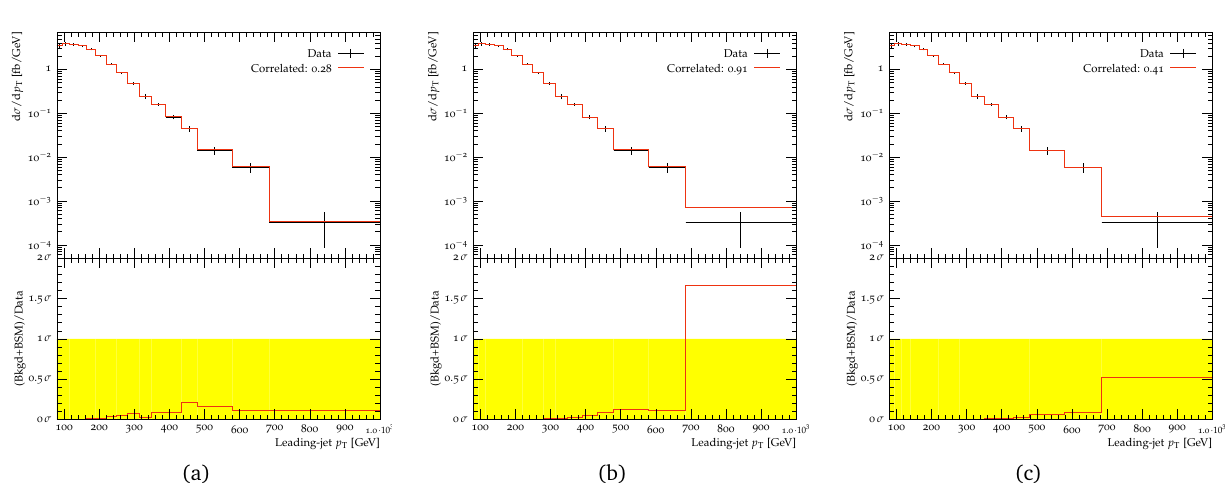
Figure 8: ATLAS 8 TeV W j j forward-lepton control region leading-jet p at three points on the 95% exclusion contour for W : Z : H = 1:0:0, respectively at M values of (a) 1000 GeV, (b) 1750 GeV, and (c) 2250 GeV. The rise and subsidence of a 90% CL exclusion from a single W j j bin is seen as the contour passes from s below 1 TeV to above 2 TeV. The black points are data, the red histogram is the VLQ contribution stacked on top of the data. In the lower insets, the ratio is shown and the yellow band indicates the significance, taking into account the statistical and systematic uncertainties on the data. The legend gives the exclusion (i.e. one minus the p -value) for that histogram after fitting nuisance parameters for the correlated systematic